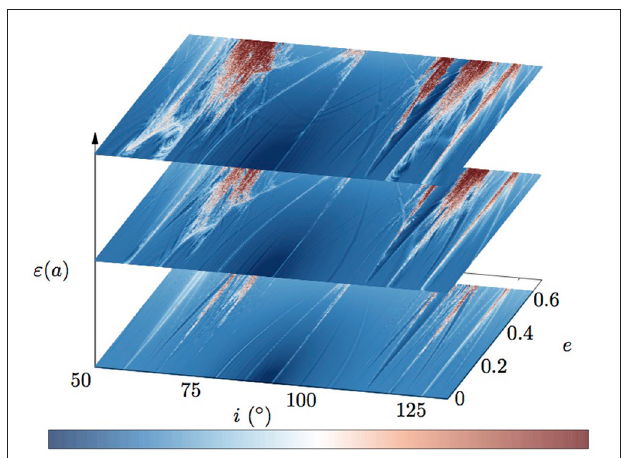
FIGURE 2 | The same as in Figure 1 apart that the values ε ( a ) correspond to the three semi-major axis 27.6,28.6,29.6 10 3 { } ×